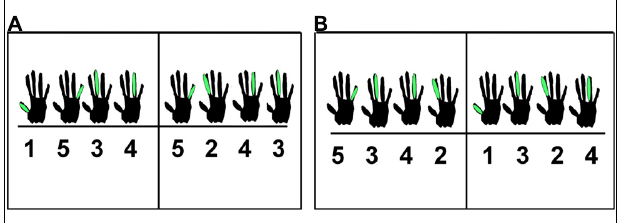
FIGURE 1 | Notation used for melody 1 (A) and melody 2